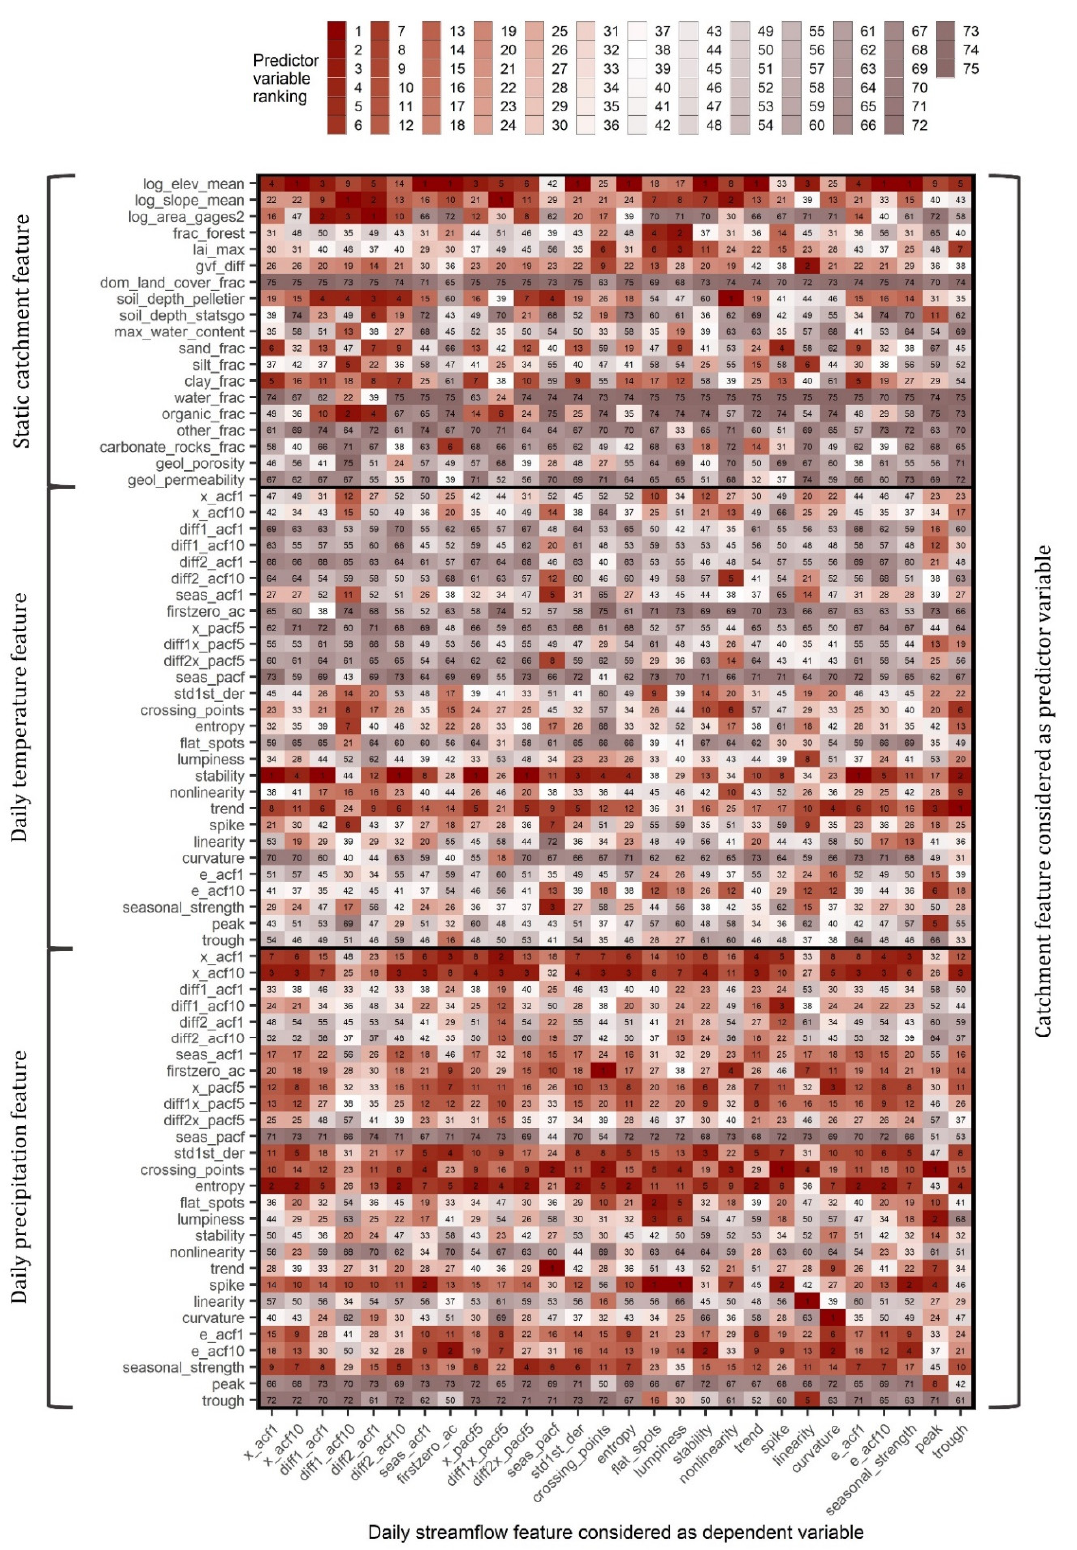
Figure 3. Rankings of potential predictor variables according to their importance in predicting various daily streamflow features. The displayed feature abbreviations are explained in Sections 2.1 and 2.2.